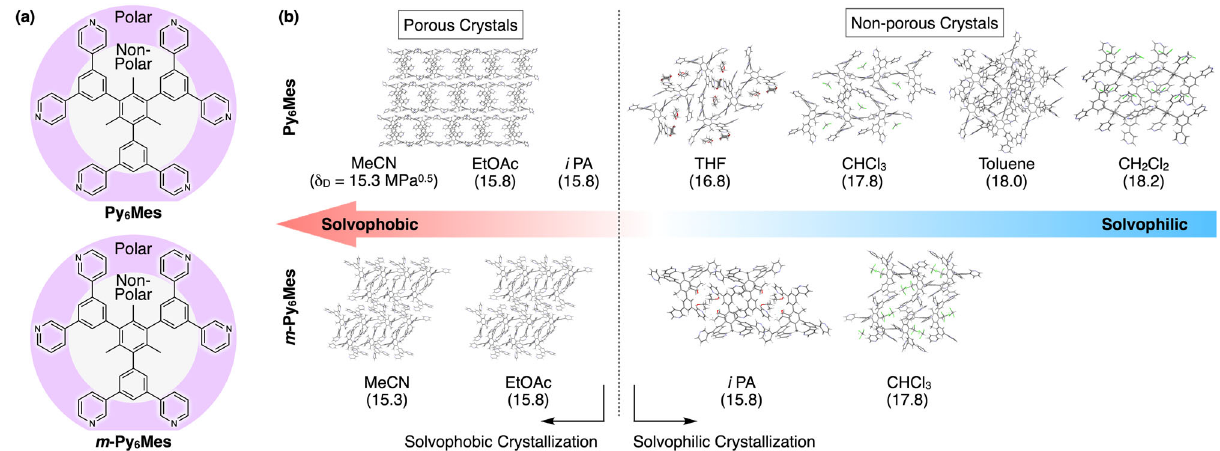
Fig. 1 Schematic representations of the δ D -dependent polymorphism of Py 6 Mes and m -Py 6 Mes. a Molecular structures of Py 6 Mes and m -Py 6 Mes with their polar peripheries and nonpolar cores highlighted in violet and gray. b Crystal packing diagrams of polymorphs of Py 6 Mes and m -Py 6 Mes . Hansen dispersion cohesion parameters ( δ D ) of the crystallization solvents are given in the